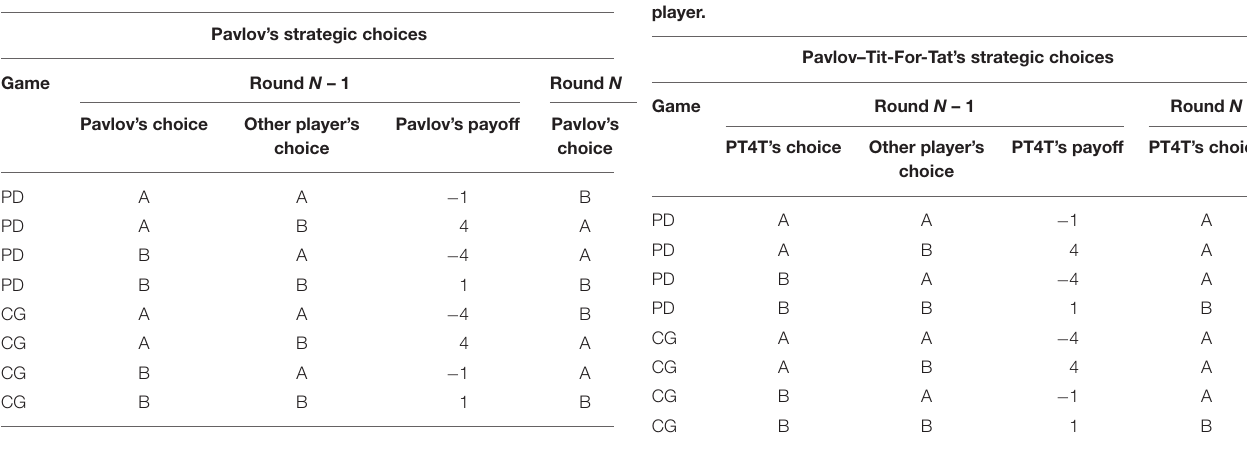
TABLE 2 | Choices that the Pavlov strategy would make on round N during both Prisoner’s Dilemma (PD) and Chicken Game (CG) based on the previous choice (round N – 1) of both the strategy and the other player.